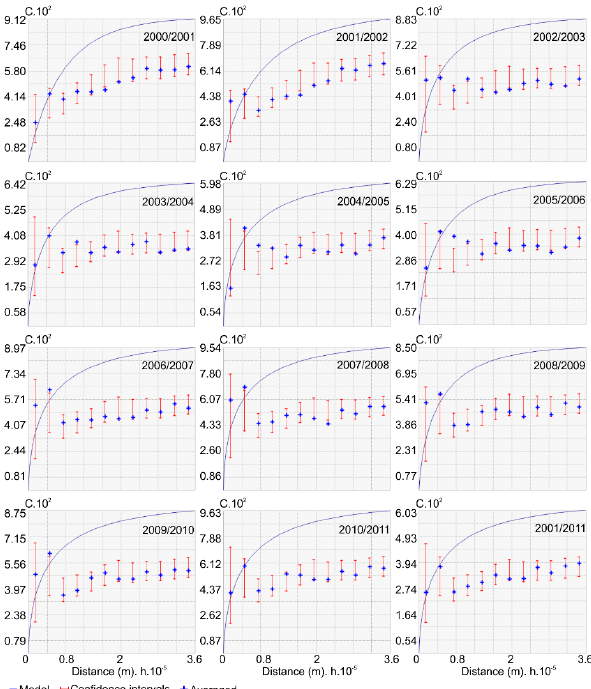
Figure 10. Empirical semivariogram values (crosses), estimated point of the stable semivariogram model (line), and bars with the 90% confidence intervals of the Gaussian areal kriging of the soybean crop yield (total number of 60-kg bags per ha − 1 ) per harvest period (2000/2001 to 2010/2011) and the averaged years (2001/2011).